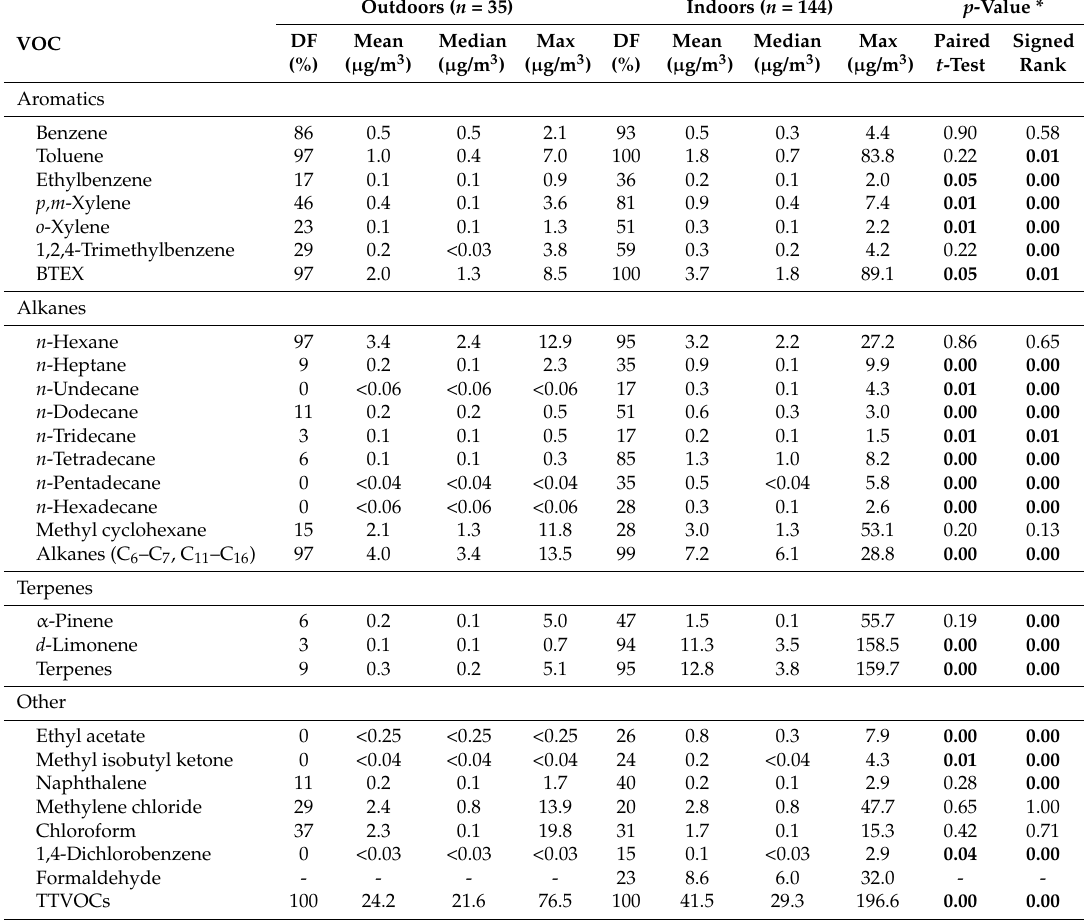
Table 1. Summary statistics of VOC concentrations in schools and